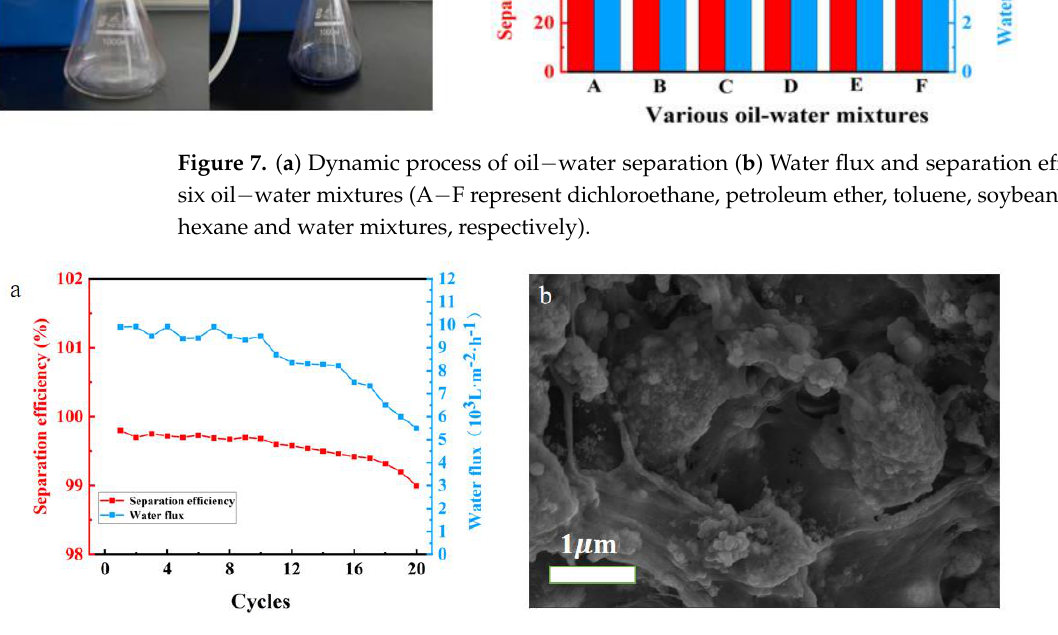
Figure 8. ( a ) Changes in water flux and separation efficiency over 20 cycles. ( b ) SEM image of BTA after 20 oil − water separation cycles.